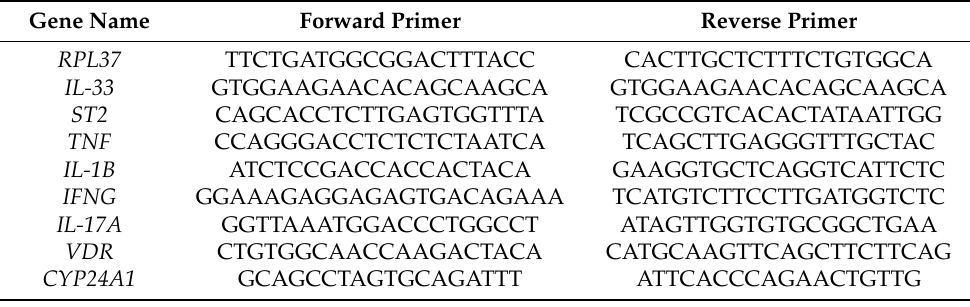
Table 1. The list of PCR primers used in the